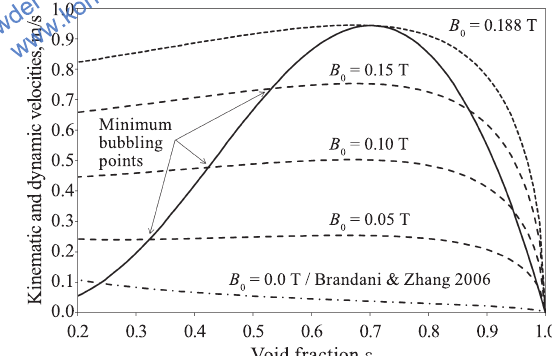
Fig. 1 Kinematic (continuous line) and dynamic wave velocities (dashed lines) as a function of the magnetic